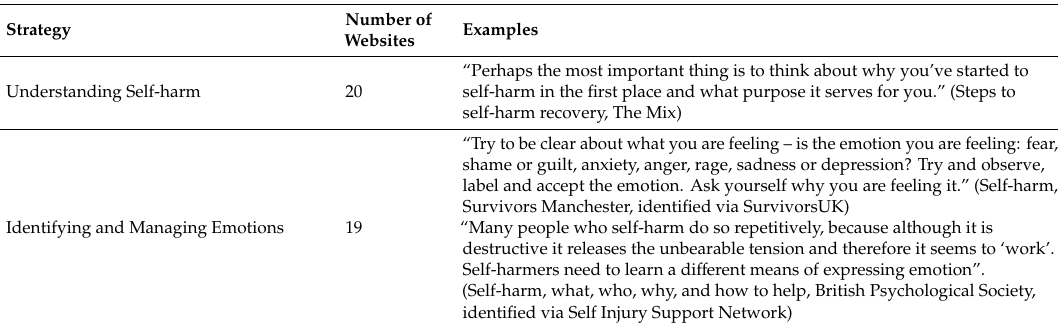
Table 3. Ways of reducing thoughts or impulses to